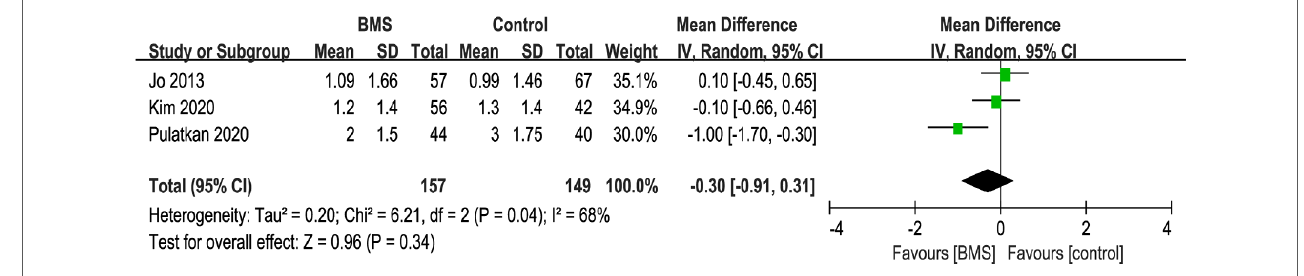
FIGURE 8 Forest plot comparing postoperative VAS score between the BMS and control groups.